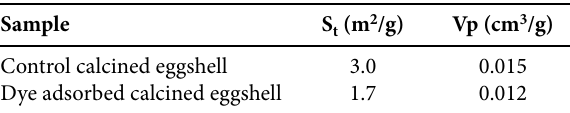
Table 2. Eggshell surface area and pore volume Sample